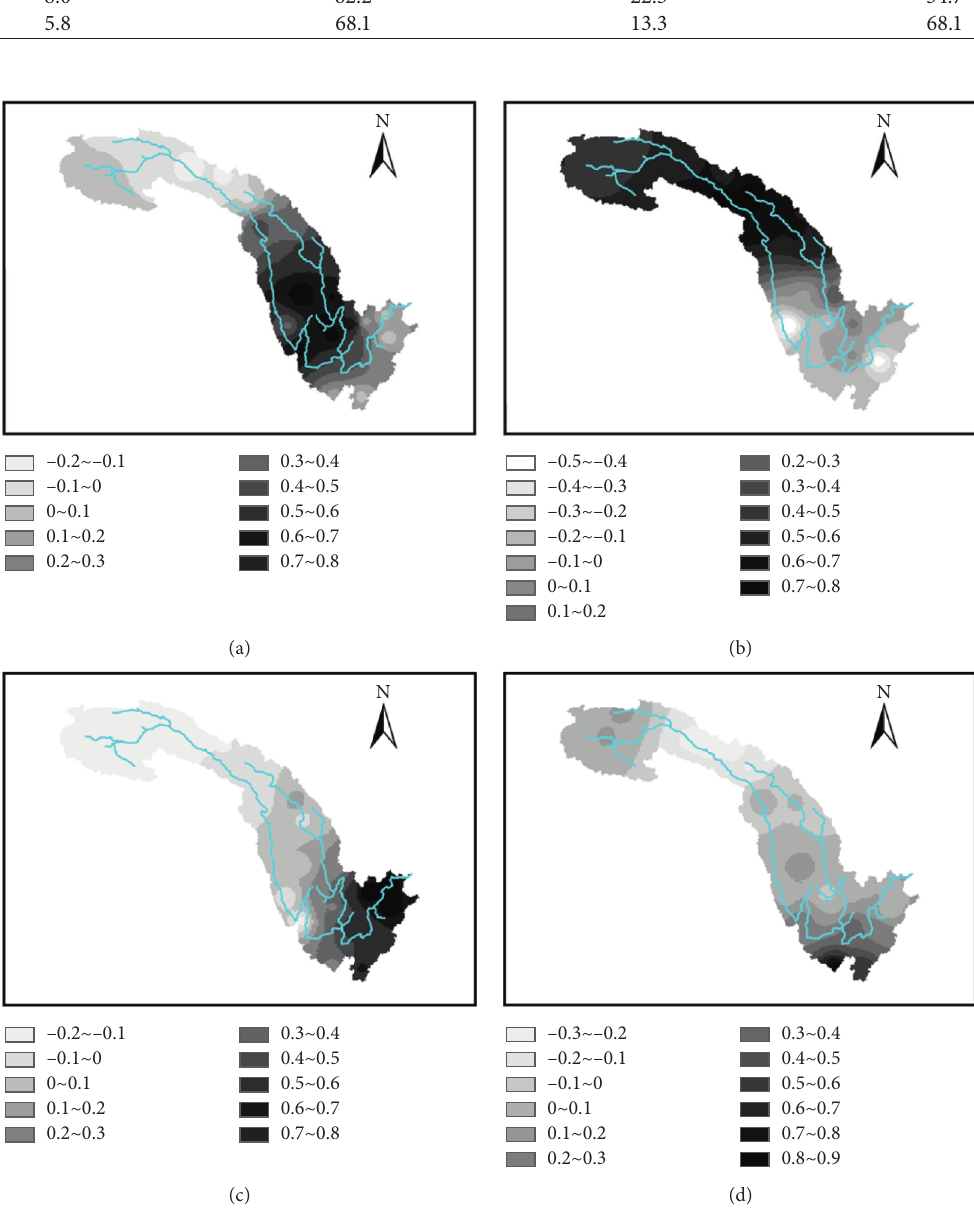
Figure 2: Distribution of the field of the (a) first, (b) second, (c) third, and (d) fourth REOF modes for the annual total precipitation in the JRB.